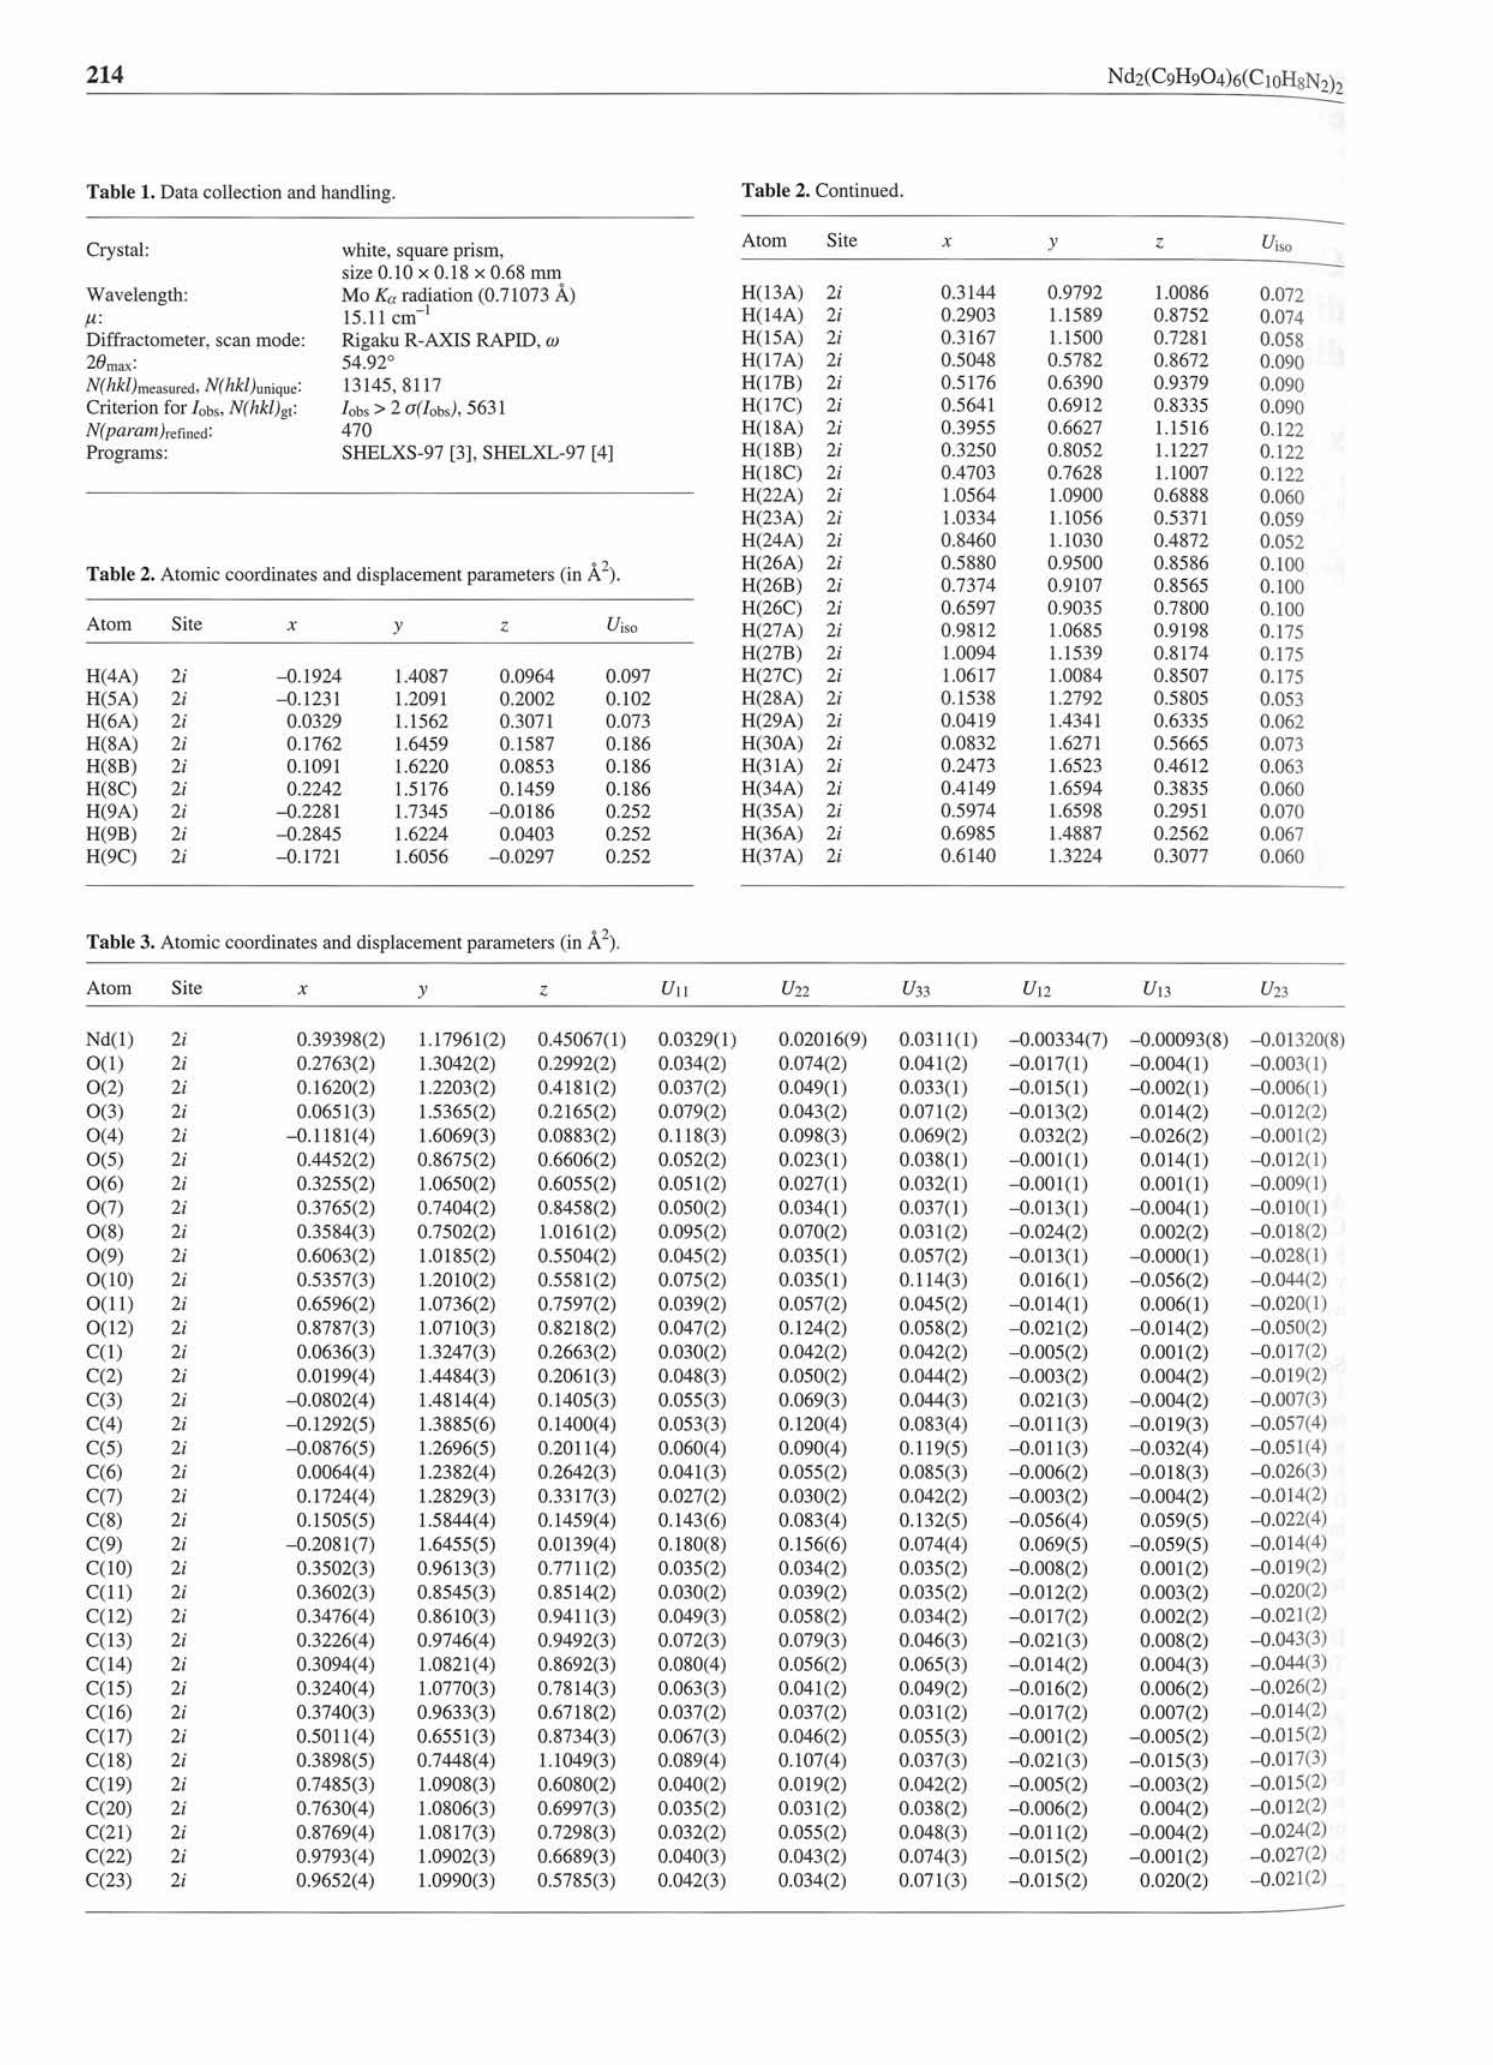
Table 1. Data collection and handling. Table 2. Continued.